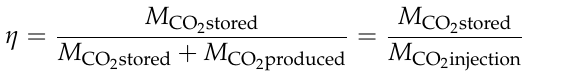
dioxide is either dissolved in crude oil or stored in the pore space. When the gas injection rate is 0.7–1.5 PV, with the increase of gas injection rate, the gas–oil ratio increases slowly, and the storage percentage decreases. For low permeability cores, when the gas injection volume is greater than 1.04 PV, the gas–oil ratio increases gradually. When the gas injection volume is greater than 1.5 PV, the gas–oil ratio increases rapidly, and the carbon dioxide storage percentage decreases. Combined with the storage percentage, it can be found that, in the reservoirs with low permeability, when the injection gas volume is 0.7~1.1 PV, the carbon dioxide storage effect is better (Figure 4). Since the core permeability is not vastly different, it is impossible to further compare the impact of permeability on the storage effect. With the increase of gas injection, crude oil recovery increases. When the gas injection is greater than 0.7 PV, the increase of crude oil recovery decreases significantly. At the same gas injection rate, the recovery of the high permeability core is greater than that of the low permeability core (Figure 5).